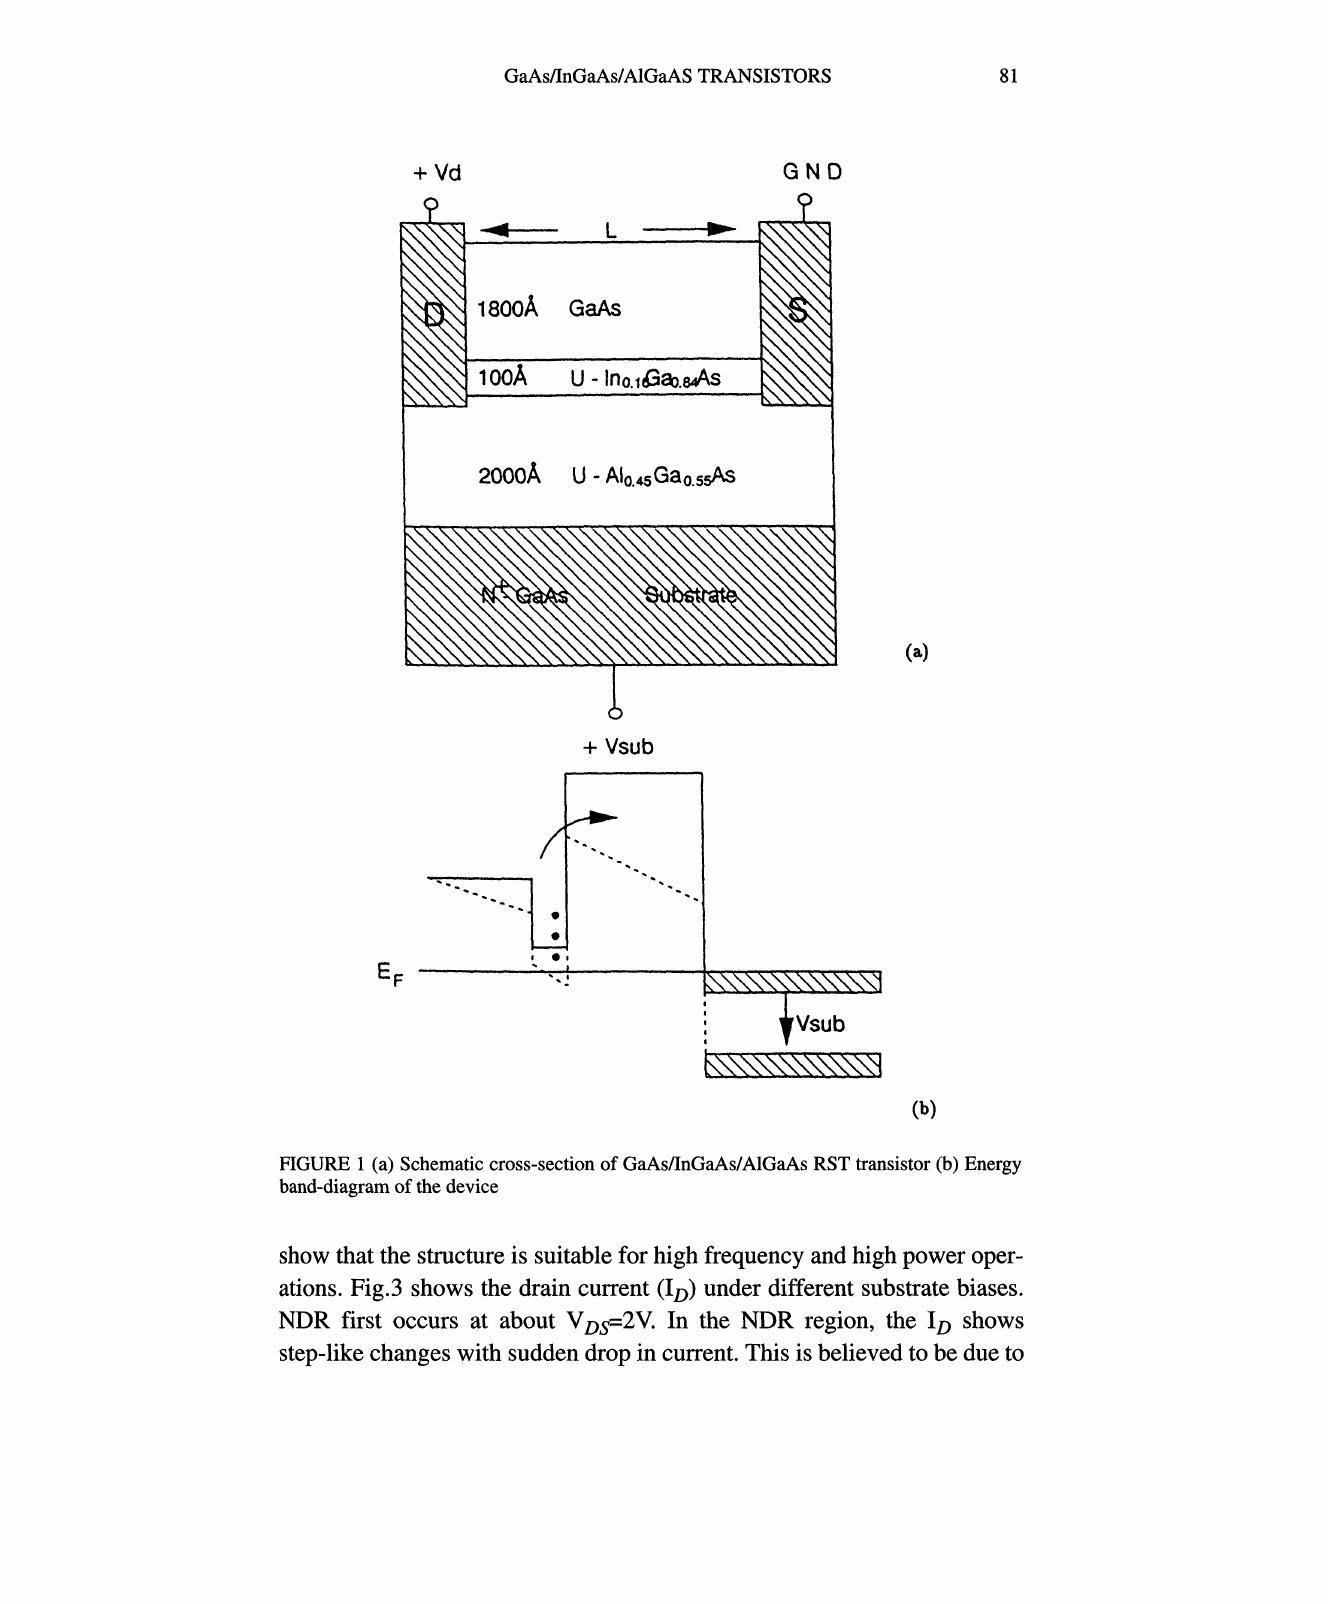
FIGURE (a) Schematic cross-section of GaAs/InGaAs/A1GaAs RST transistor (b) Energy band-diagram of the device show that the structure is suitable for high frequency and high power oper- ations. Fig.3 shows the drain current (ID) under different substrate